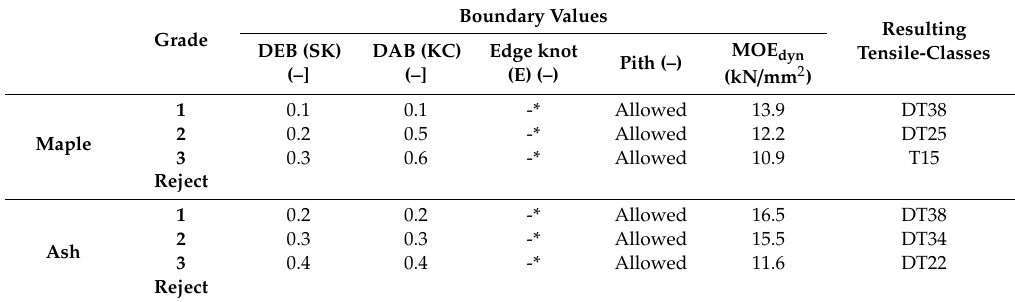
Table 3. Optimized grading rules for combined visual and machine strength grading of ash and maple (according to Kovryga et al. [31]; maple: “Solution B”, ash: “Solution C”). Boundary Values Grade